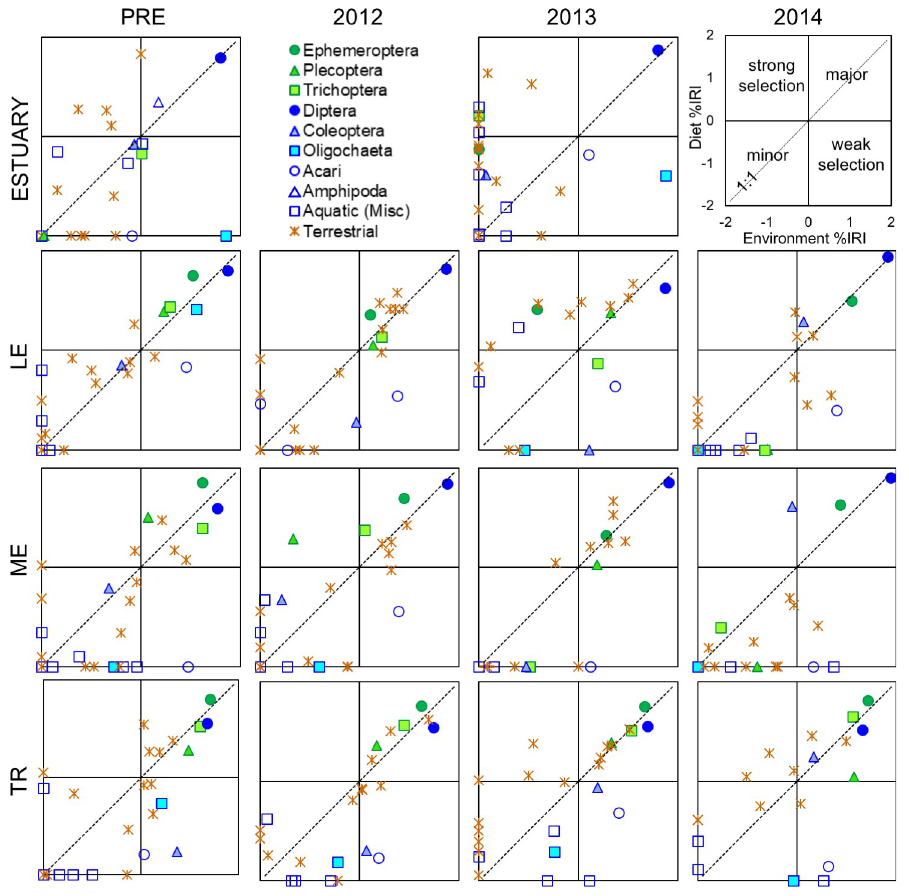
Fig 11. Index of Relative Importance (% IRI) for invertebrates present in summer environmental (x-axis) and diet (y-axis) samples. Data are log 10 transformed (i.e., 0.1% = - 2, 100% = + 2), and plotted by study section and year. Each terrestrial data point represents a different order. Orders that contributed < 0.1% to IRI are plotted at -2. Graphs do not include taxa consumed by fish but not present in environmental samples (i.e., plankton in the estuary, and fish in estuary and